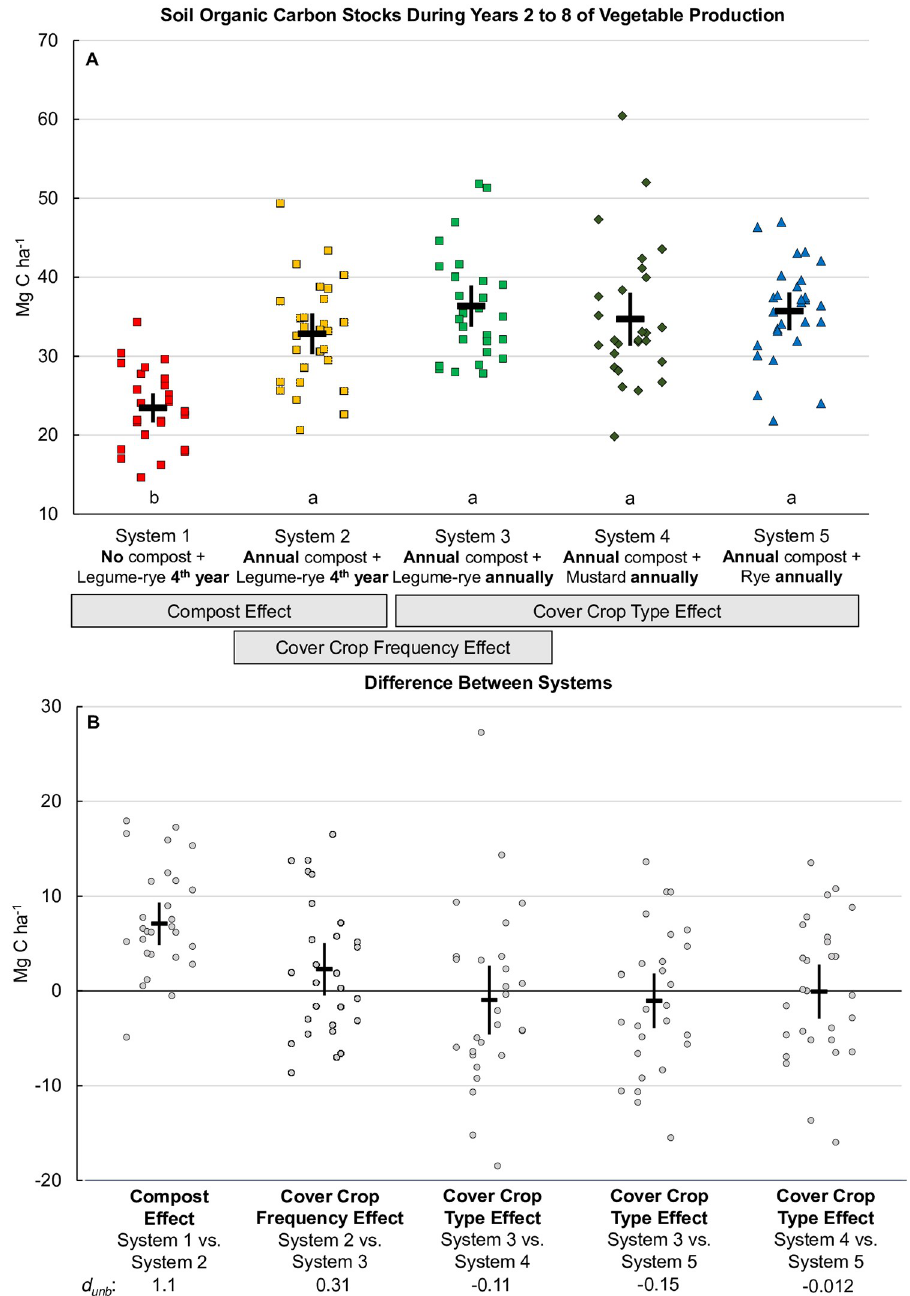
Fig 6. Soil organic carbon stocks during years 2 to 8 of vegetable production. Measurements were taken at the 0 to 30 cm depth. Mean soil organic carbon stocks for years 2 through 8 (A) and mean differences between systems (B) in five organic vegetable systems in Salinas, CA. Error bars are 95% confidence limits. Systems differed by annual compost additions (0 vs. 7.6 Mg ha -1 before each vegetable crop), cover crop type (legume-rye, mustard, or cereal rye alone) and cover cropping frequency (quadrennially vs. annually planted). In plot A the individual data points are in order of year 2 to 8 and replicate 1 to 4 from left to right; the same order is used in the difference between system pairs. The error bar in the center of the data cluster is the 95% confidence interval with the mean at the horizontal line. Means with the same letter above the x-axis in plot A are not significantly different based on the Tukey-Kramer adjusted family-wise error rate of (P � 0.05). The standardized effect size (Cohen’s unbiased d , d unb ) is shown below the x-axis labels in plot B.